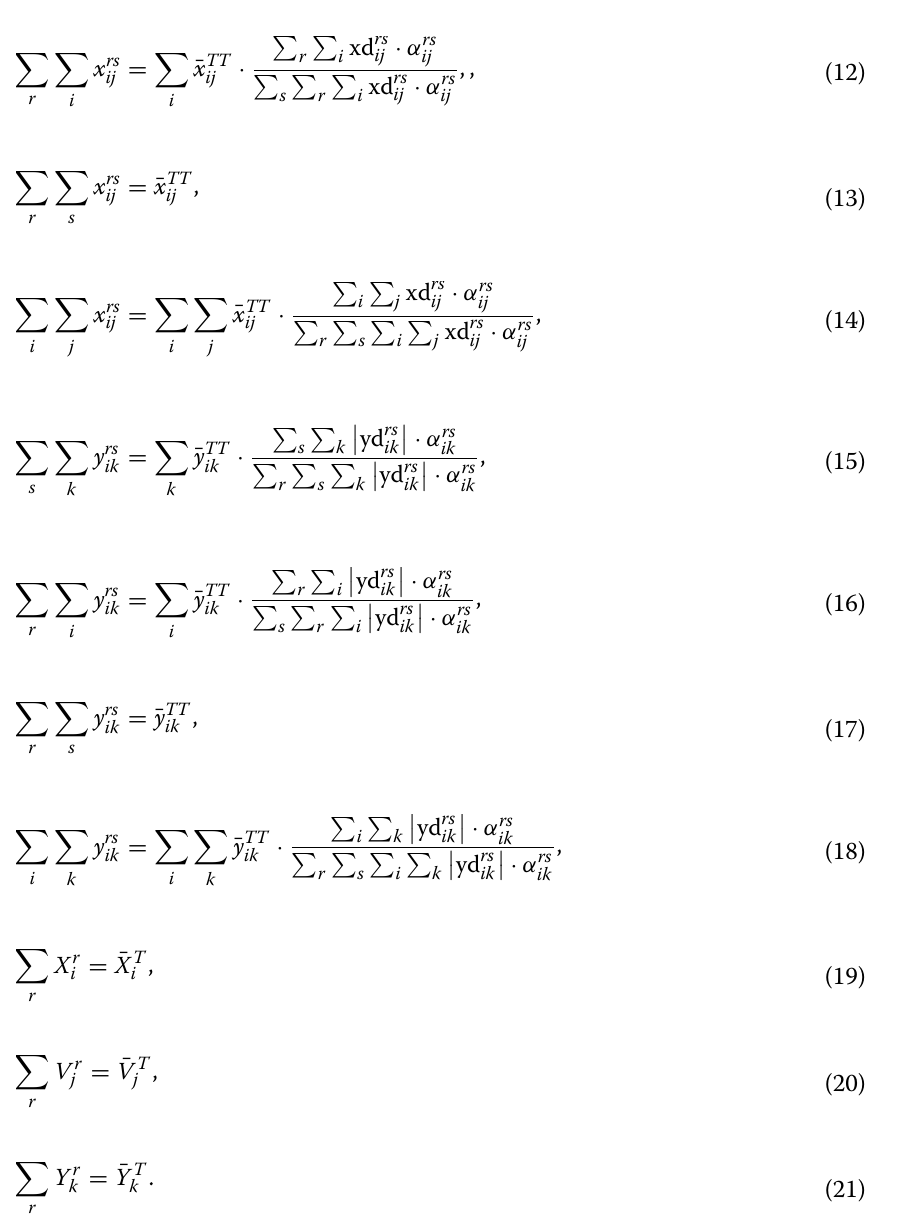
The balancing conditions row-wise (row control totals) are given by Eq. (11) for intermediate product transactions and by Eq. (15) for final product transactions. The balancing conditions column-wise (column control totals) are given by Eq. (12) for intermediate product transactions and by Eq. (16) for final product transactions. Equa- tions (13) and (17) represent the control totals for inter-industrial intermediate and final product transactions, respectively. Equations (14) and (18) give the control for inter- regional intermediate and final product transactions, respectively. Equations (19–21) give the control for sectoral output, value added, and final